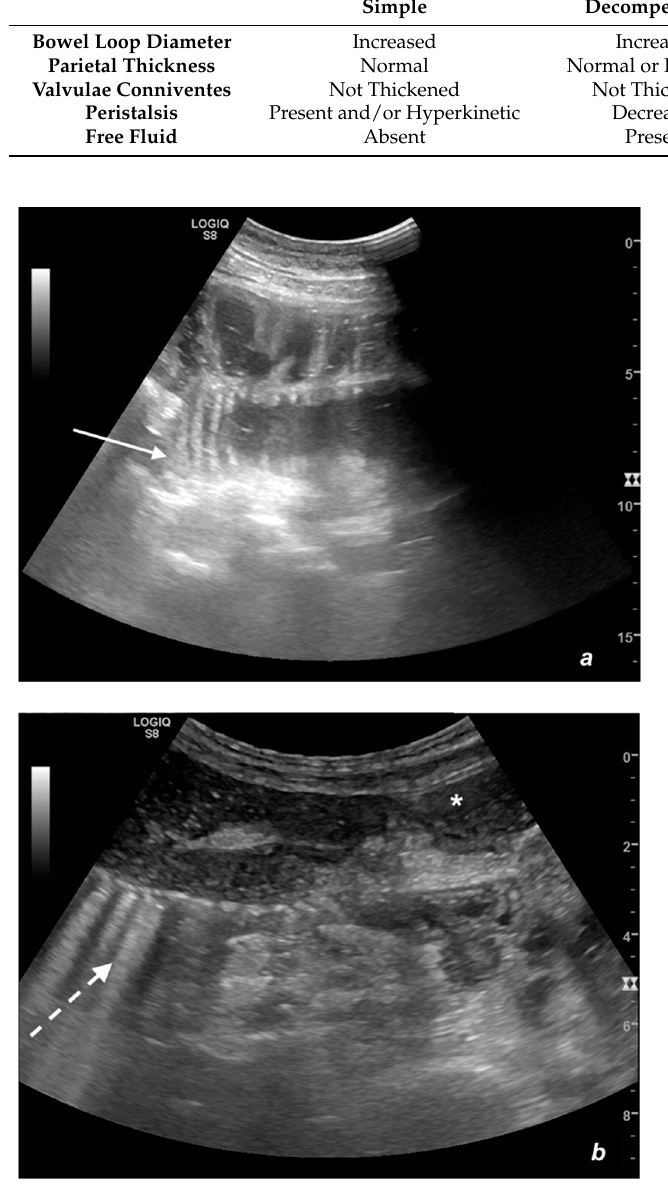
Figure 1. ( a , b ). A simple SBO. Ultrasound images show fluid-filled, dilated small bowel loops ( a , b ) with hyper-kinesis and hyper-representation of valvulae conniventes (white arrow) ( a ); tail comet artifacts are visible due to air-fluid levels (dashed arrow) ( b ) and groups of bowel loops with severe differences in diameter (‘bowel jump diameter’) are evident more superficially (*) ( b ). No free fluid was detected in the abdominal cavity or between bowel